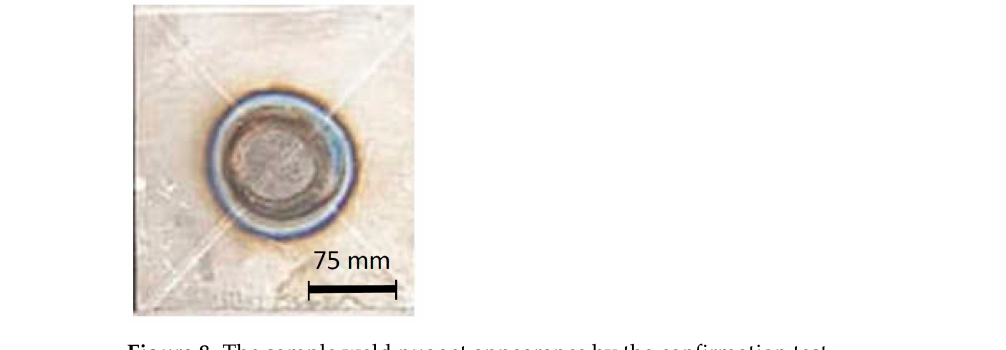
Figure 8. The sample weld nugget appearance by the confirmation test. Table 6. Confirmation test results of the sample tensile-shear testing results.